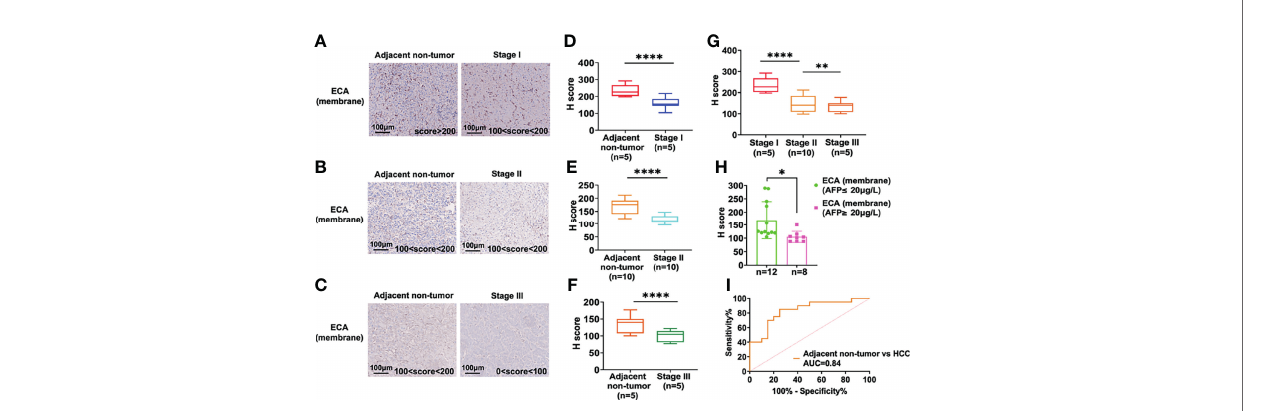
FIGURE 2 | IHC analysis of the ECA-binding galactosylated glycans in the different stages of HCC and adjacent non-tumor tissues. (A – F) IHC analysis of staining intensity of glycans binding with ECA on cell membrane proteins among HCC tissues and adjacent non-tumor tissues. Images are stained as brown (HRP-avidin plus biotin-conjugated ECA) and blue (hematoxylin, nuclei). (A – C) are representative data for (D – F) . (D, E) are statistical analysis for (A – C) , respectively. (G) Comparison of staining intensity of ECA between different stages of HCC tissues. (H) Correlation analysis of serum AFP levels and ECA binding af fi nity. (I) ROC curves analysis of